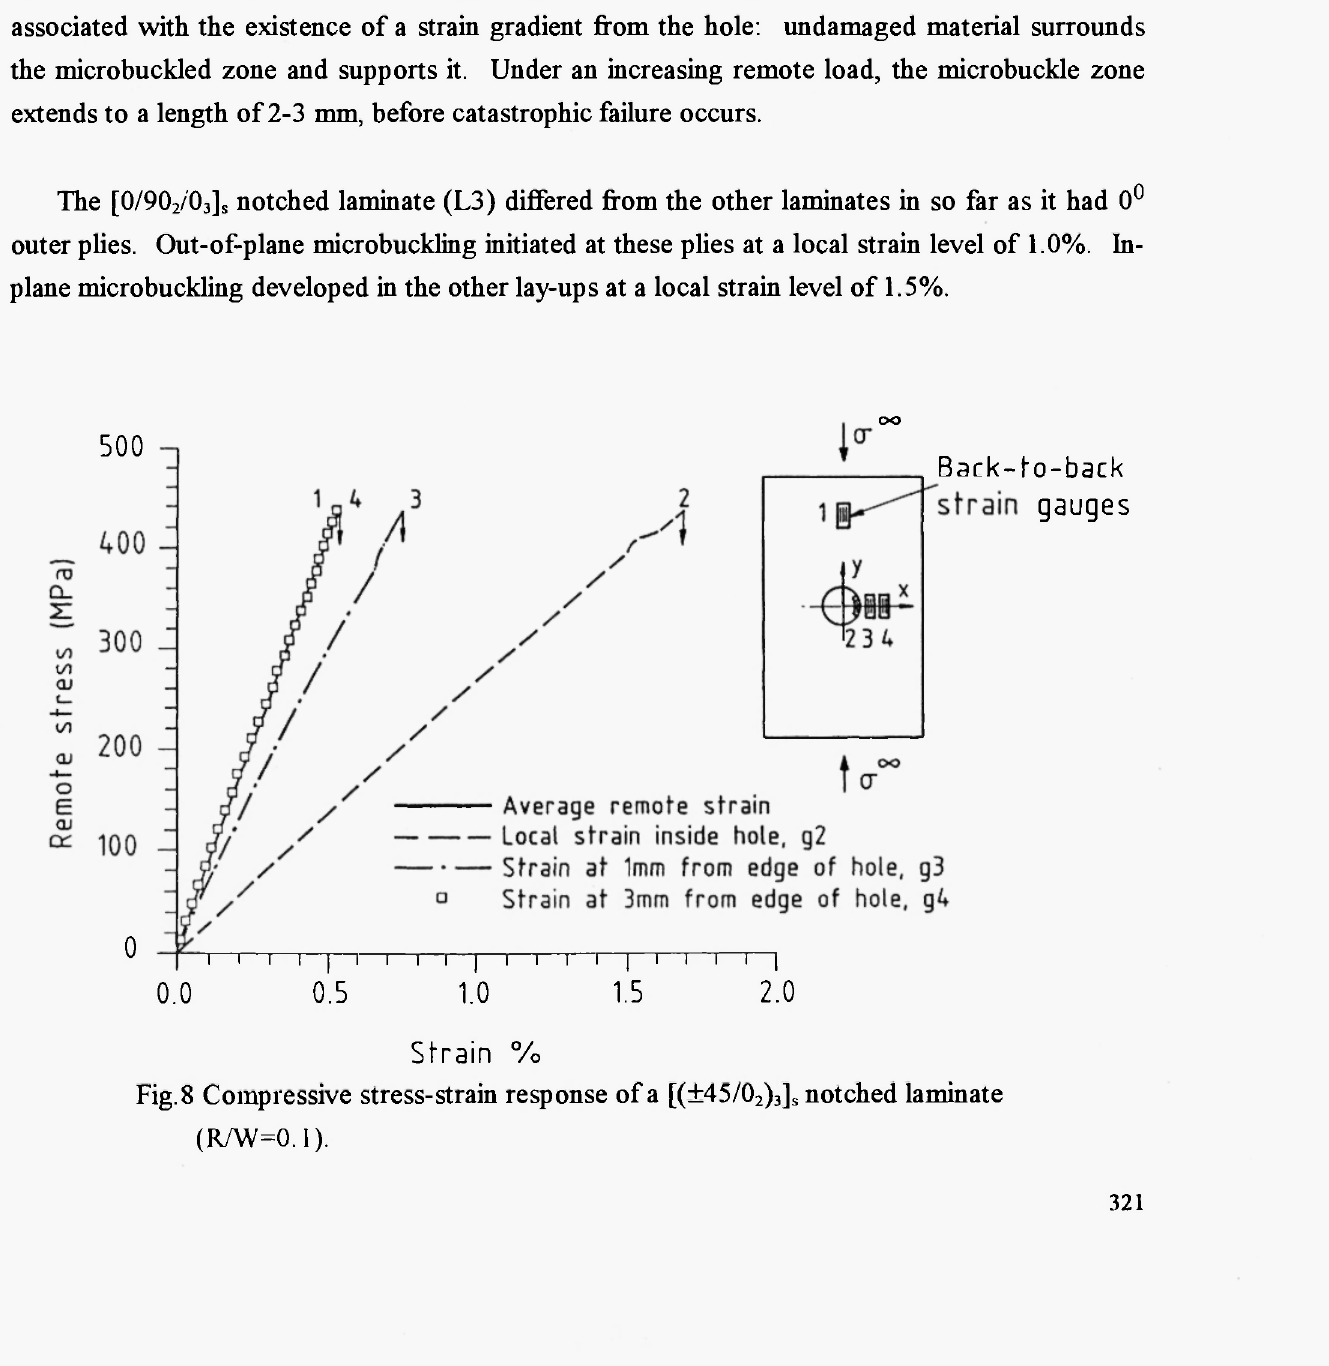
) ] notched laminate 2 3 s